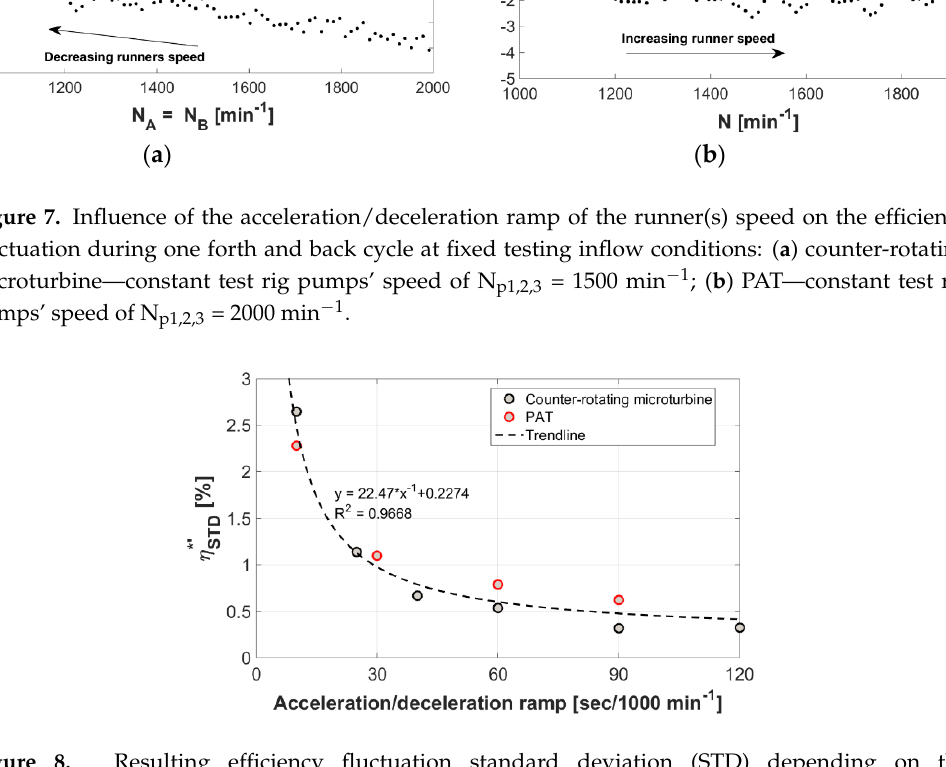
Figure 8. Resulting efficiency fluctuation standard deviation (STD) depending on the acceleration/deceleration ramp.